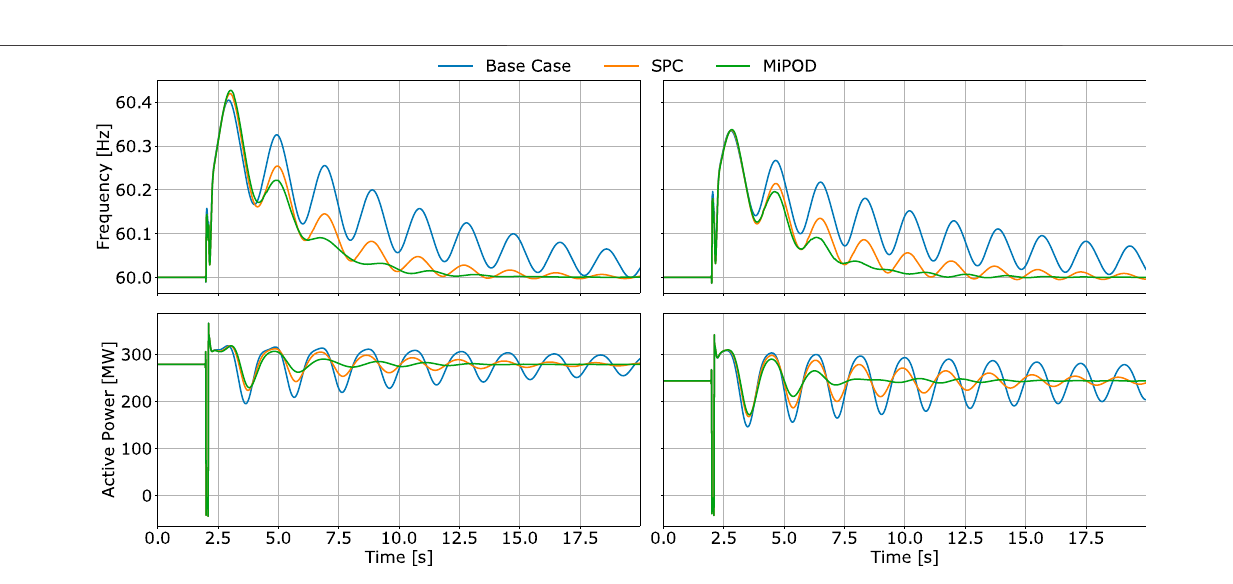
Frontiers in Energy Research |